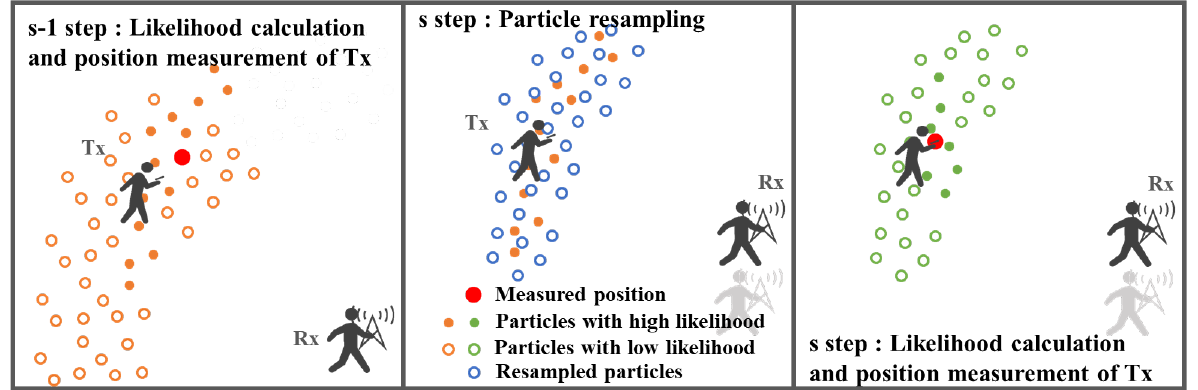
Figure 4. Flow of position estimation by particle filter. Left: likelihood calculation and position measurement in previous step. Center: resampling of particles when the Rx is moved in current step. Right: likelihood calculation and position measurement in current step.